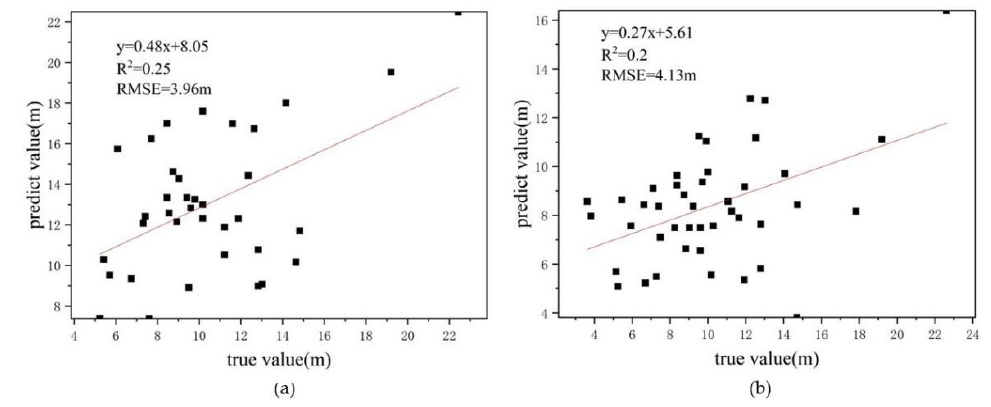
Figure 15. DEM differential interference method with multilayer perceptron estimation of tree height precision and fitting equation ( a ). Coherent amplitude method with multilayer perceptron estimation of tree height precision and fitting equations ( b ).